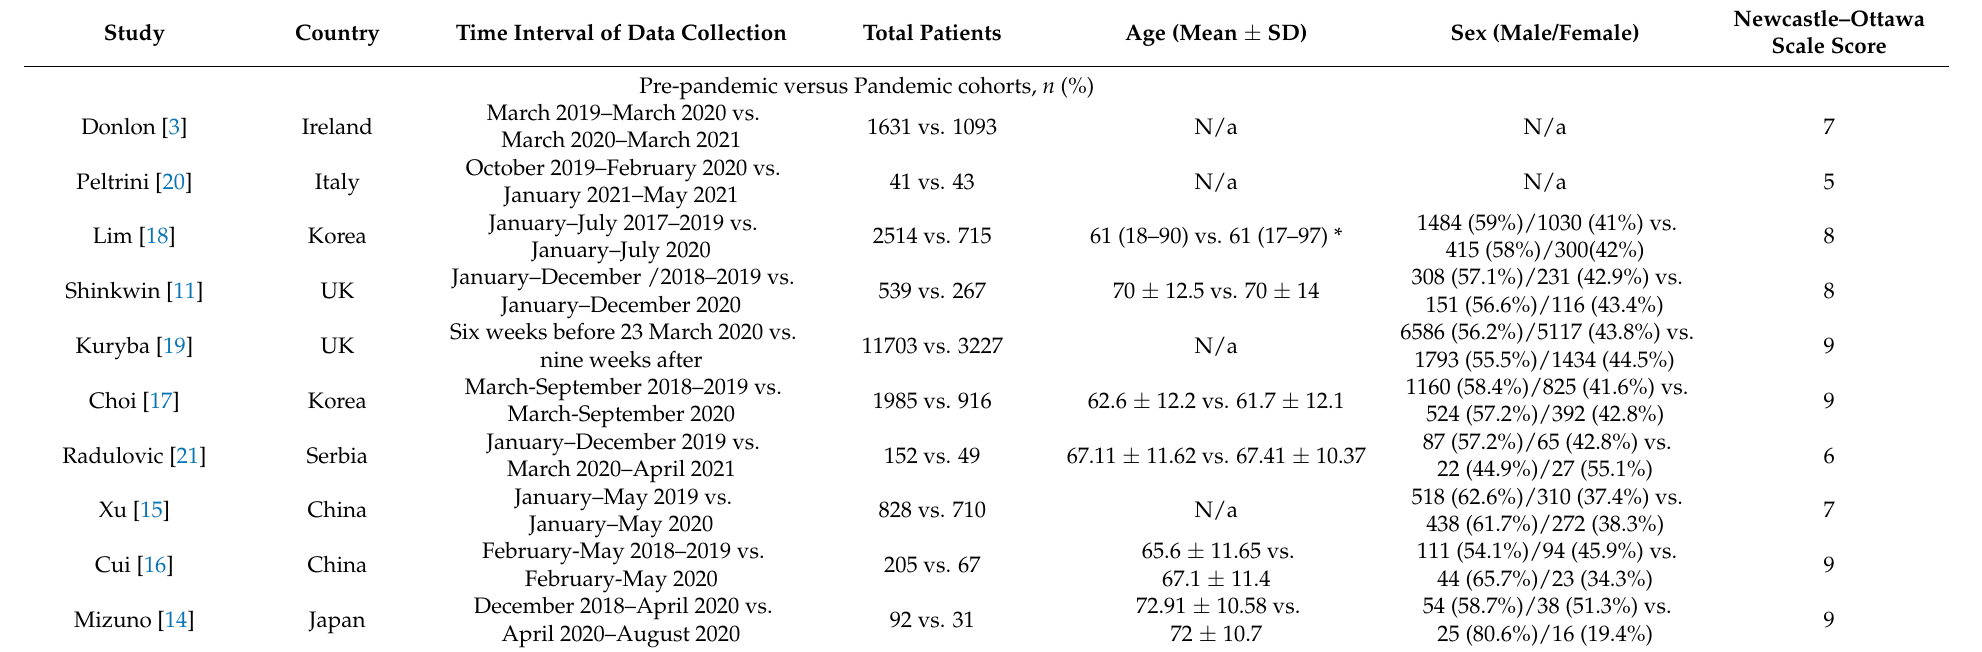
Table 1. Included study